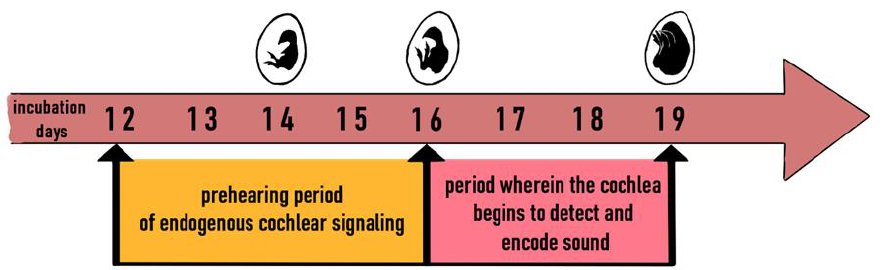
Figure 4. The perception of sounds by the chicken embryo from 12th to 19th day of incubation. Own elaboration based on [85].